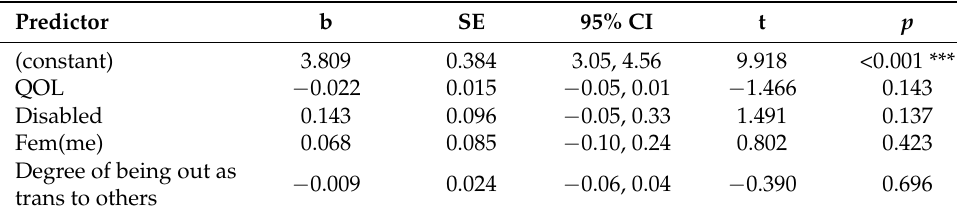
Table 5. Predicting COVID-19 impact by QOL and biosocial